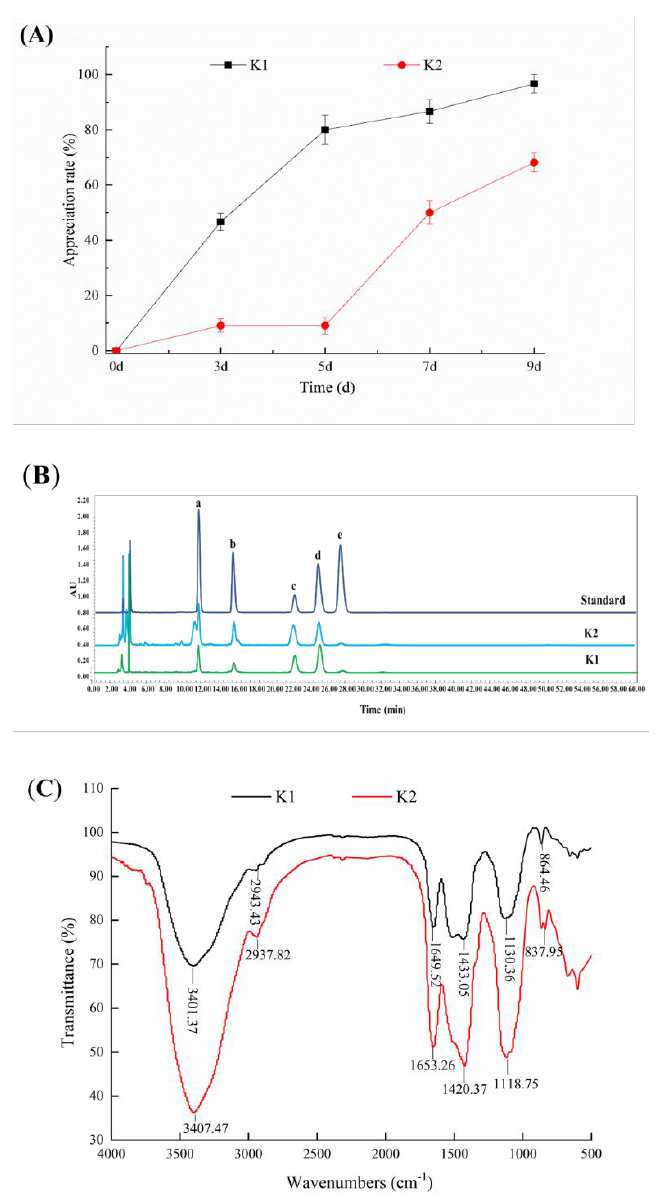
Figure 3. Proliferation of kefir grains ( A ), monosaccharide composition ( B ) and FTIR spectra ( C ) of kefir r-EPS. Monosaccharide standards: mannose (a), rhamnose (b), glucose (c), galactose (d) and arabinose